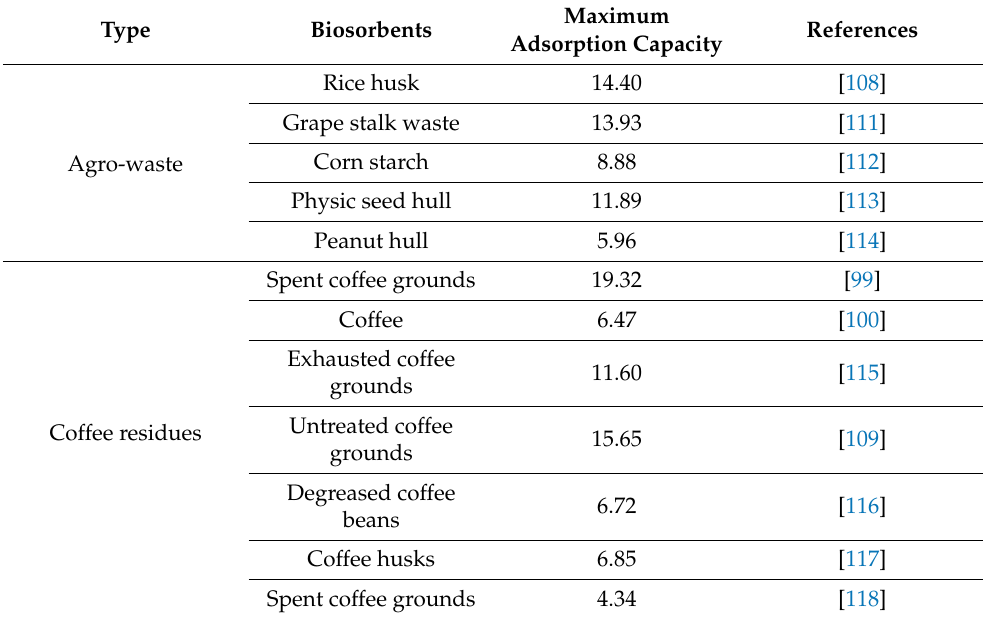
Table 7. Comparison of maximum Cd adsorption capacity ( q m , mg g − 1 ) of spent coffee grounds and other agro-waste reported in